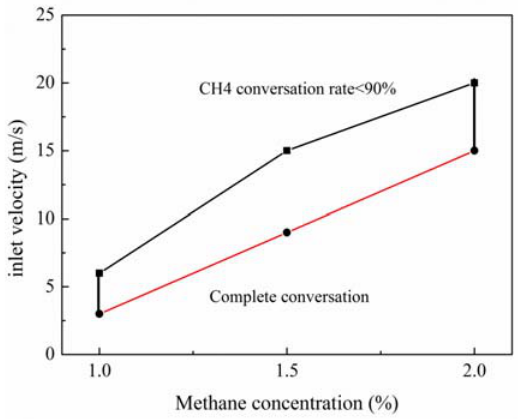
Figure 8. Operational map for methane catalytic combustion on Pt. λ w = 5 W/m/K.